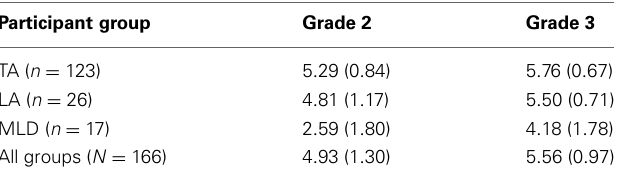
Table 1 | Mean (and SD) number of correct responses out of 6 on Written Numbers Task among children with TA, LA, or MLD.